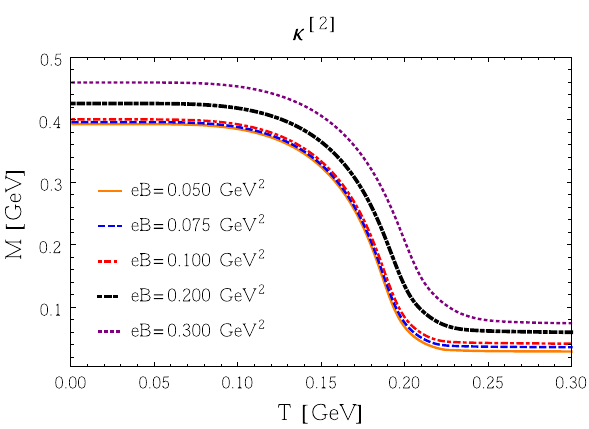
Fig. 2 Effectivequarkmassasfunctionofthetemperaturefordifferent values of fixed magnetic field strength. For these results, was adopted the set κ [ 2 ]